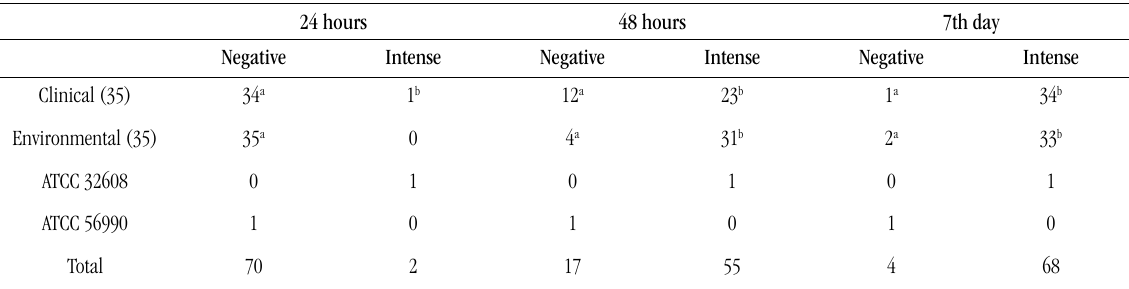
tABLE 9 – Protease production activity in clinical and environmental Cryptococcus neoformans and Cryptococcus gattii samples isolated in Sergipe, Brazil